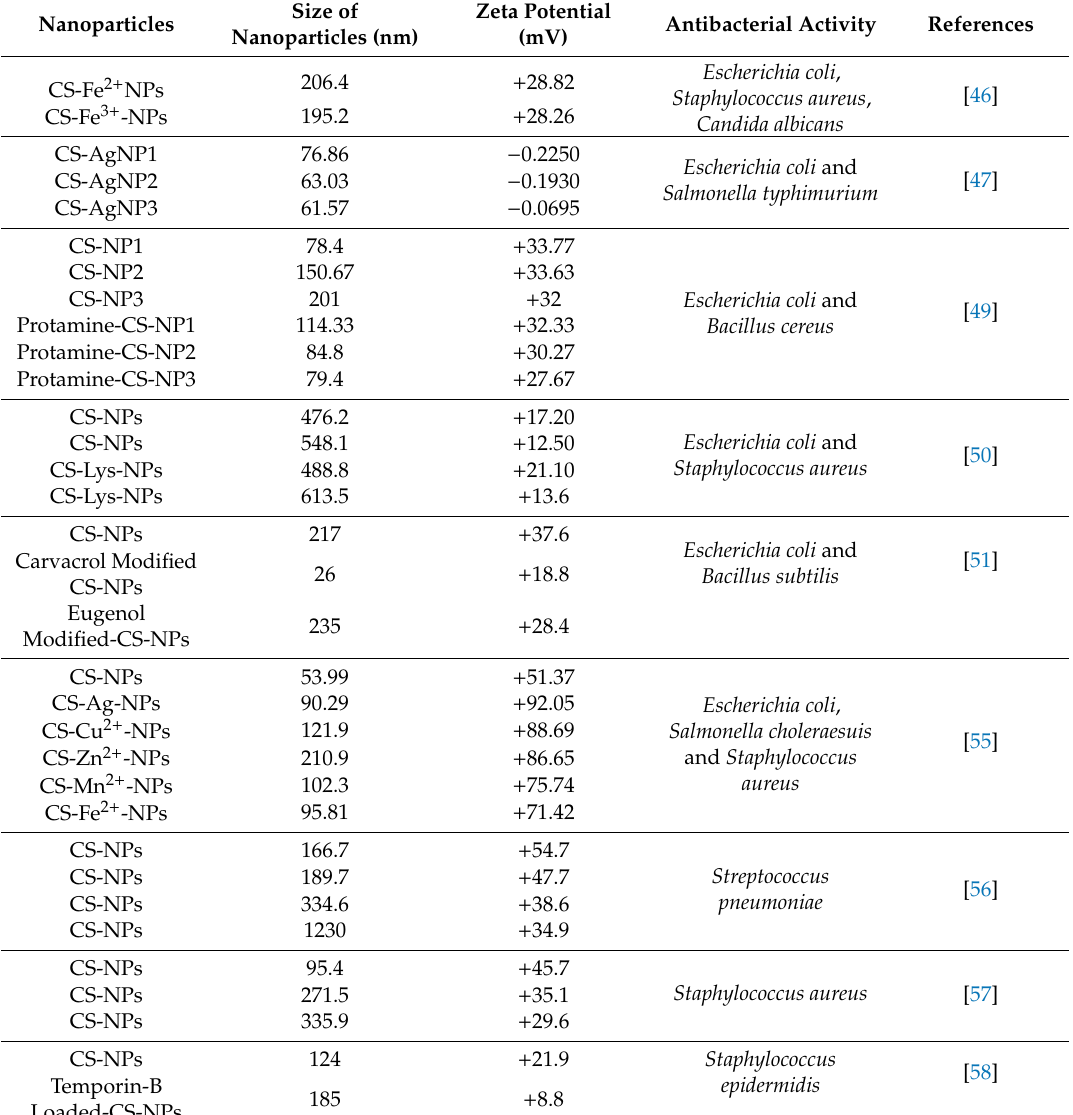
Table 1. Antibacterial activity of chitosan nanoparticle in relation to size of nanoparticles and zeta